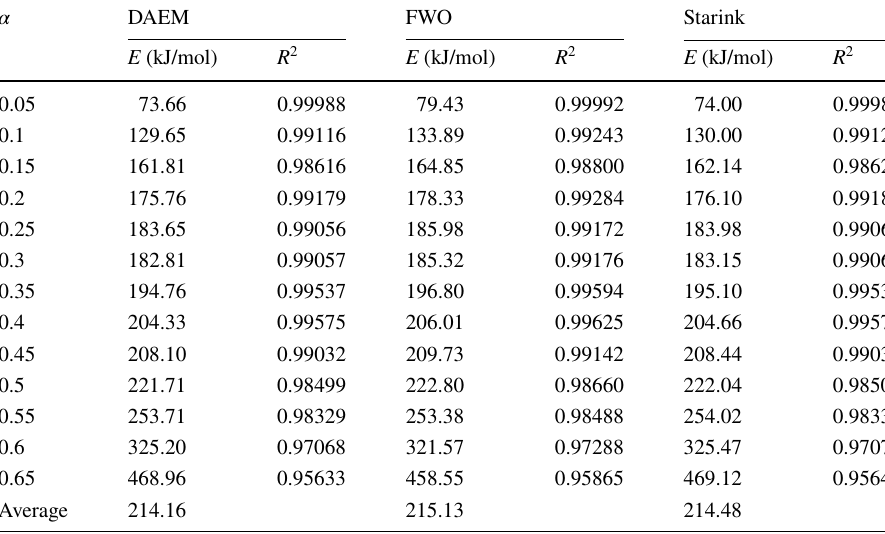
Table 10 Apparent activation energy of LPS-R pyrolysis determined by Starink, FWO and DAEM